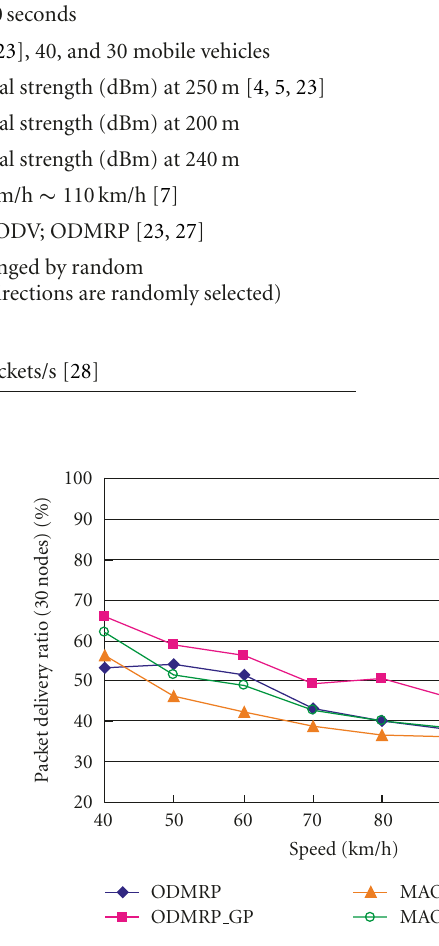
Figure 11: Packet delivery ratio versus mobility speed (50 nodes).